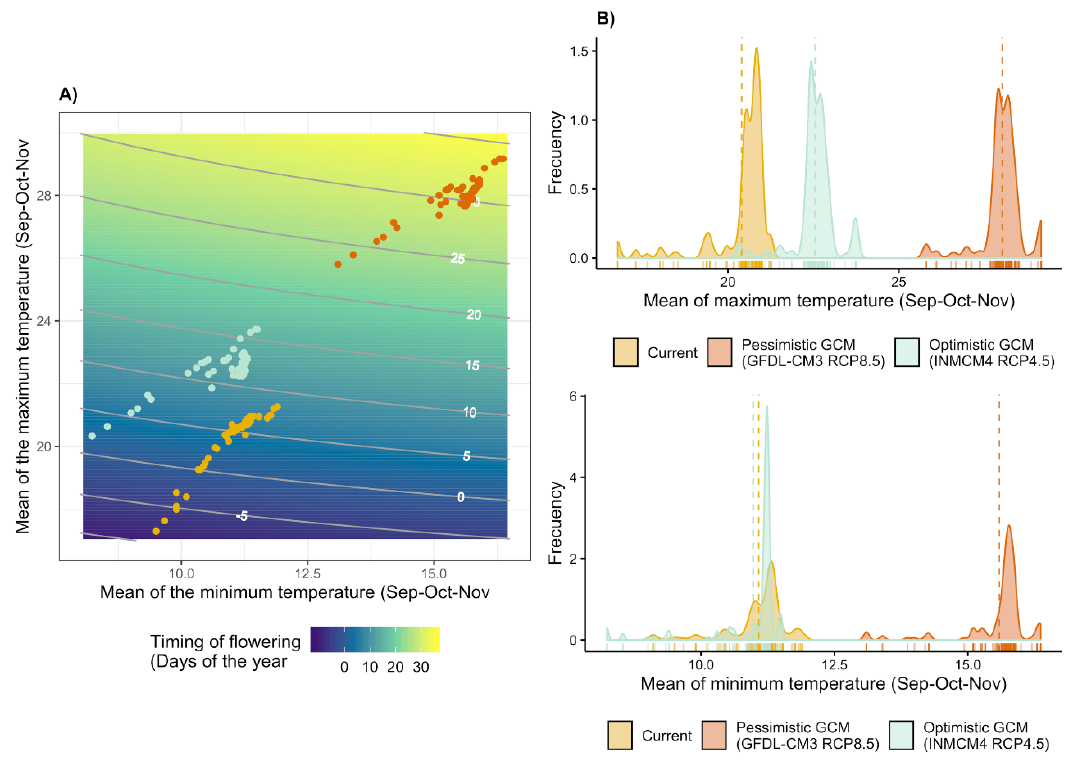
Figure 8. Future estimates based on the most optimistic and pessimistic emission scenarios according to the results of the Figure 6. A, changes to the timing of flowering; B, changes in maximum and minimum temperatures according to the selected General Circulation